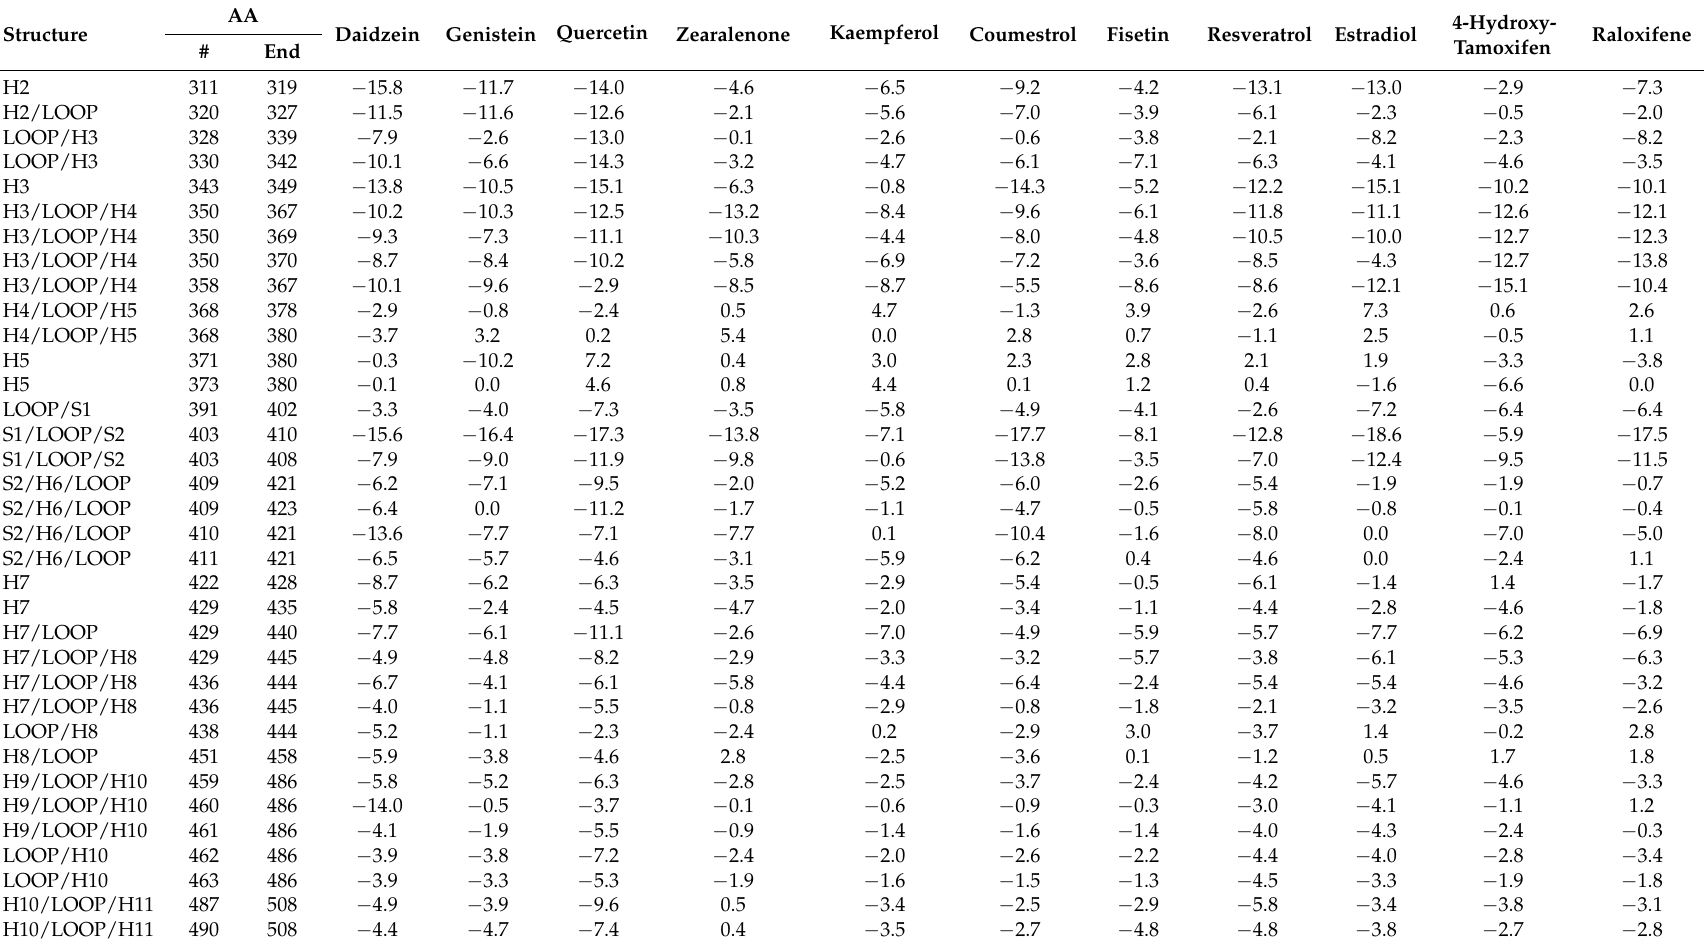
Table 2. Average differences in deuteration levels (in %) of apo ER α LBD in the presence of different